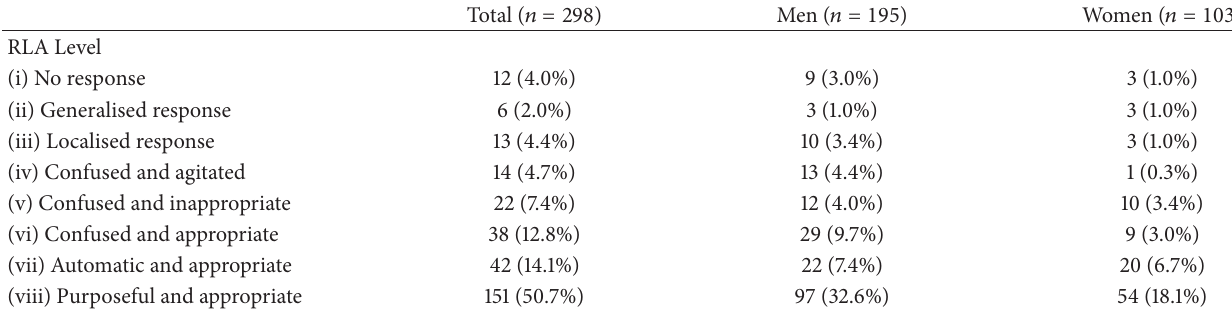
Table 4: RLA in 298 patients with TBI.